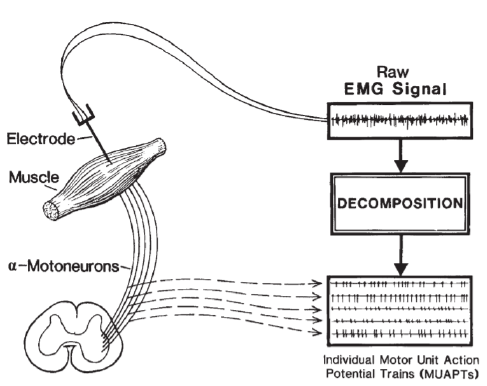
Figure 1. EMG signal composition and how it can be decomposed [7].